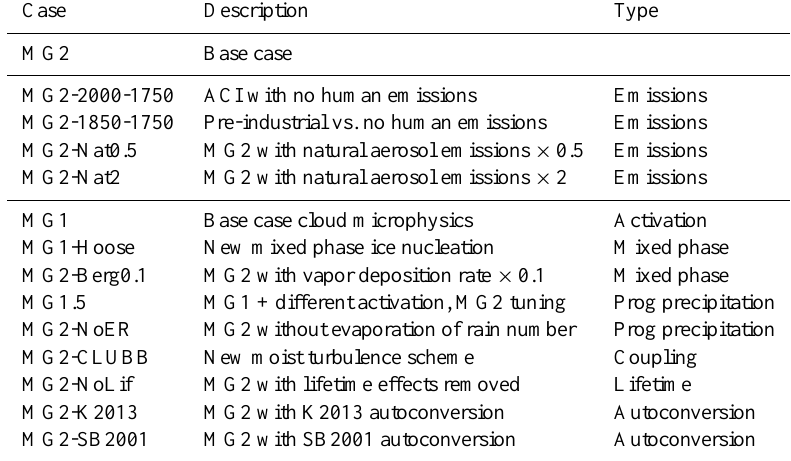
Table 1. Description of sensitivity tests used in the text, including the case short name (including the microphysics scheme used), a brief description, and the type of experiment. All tests are pairs of simulations as described in the